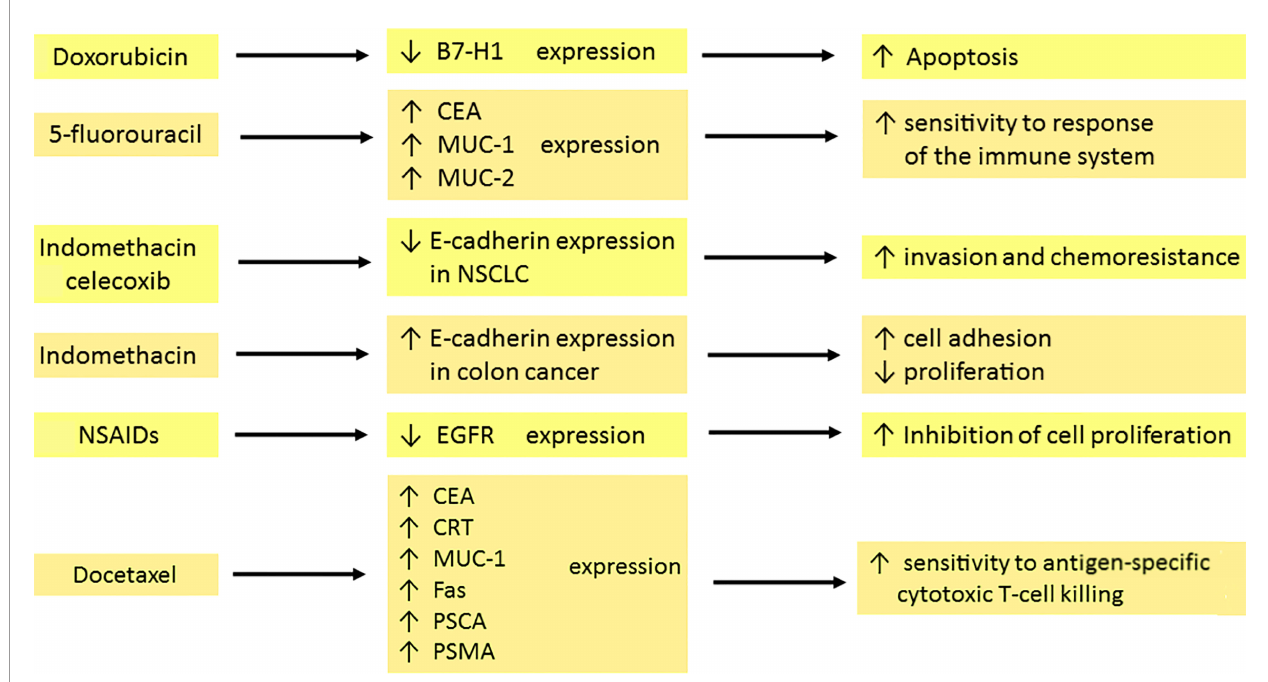
FIGURE 2 | Effects of chemo- and pharmacotherapy of the tumour on the expression of membrane antigens. Doxorubicin, through the inhibition of surface anti- apoptotic B7-H1 expression in breast cancer, is involved in the initiation of cell death. 5 – fl uorouracil enhances CEA, MUC-1 and MUC-2 expression, which is associated with sensitization of the immune system. Indomethacin and celecoxib decrease the expression of E-cadherin in NSCLC, which leads to ampli fi ed invasion and drug resistance development. In contrast, indomethacin in colon cancer increases E-cadherin expression. Therefore, tumour cells have a stronger capacity for adhesion but diminished proliferation. The reduction of EGFR expression by NSAIDs contributes to the inhibition of cell proliferation. Docetaxel upregulates the expression of CEA, CRT, MUC-1, Fas, PSCA and PSMA. The result is a high sensitivity to killing by cytotoxic T cells. carcinoembryonic antigen (CEA), mucin-1 (MUC-1), mucin-2 (MUC-2), non – small cell lung cancer (NSCLC), nonsteroidal anti-in fl ammatory drugs (NSAIDs), calreticulin (CRT), prostate stem cell antigen (PSCA), prostate-speci fi c membrane antigen